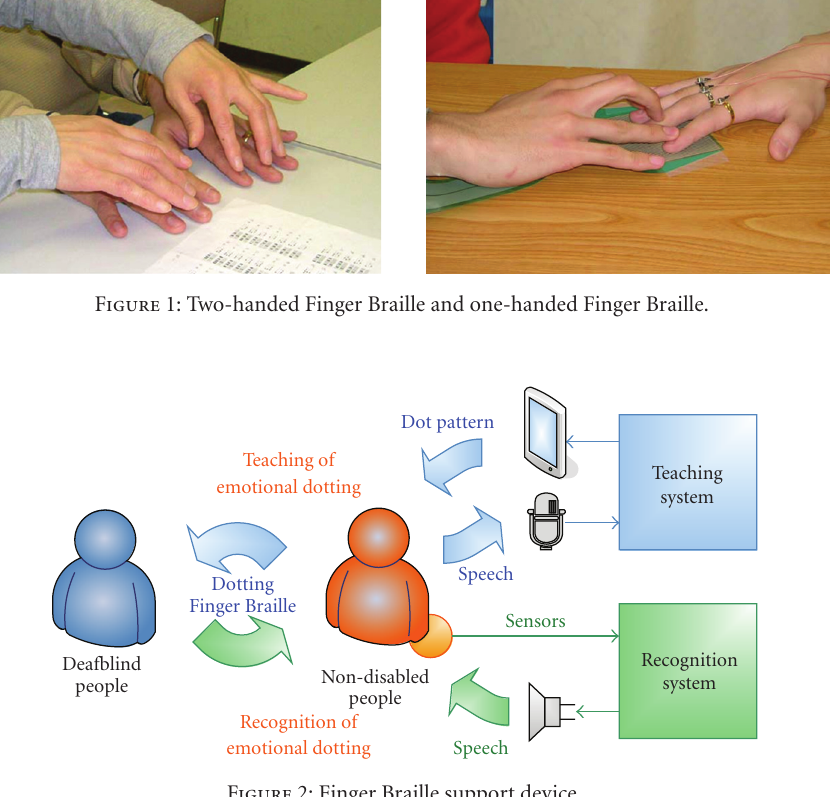
Figure 2: Finger Braille support